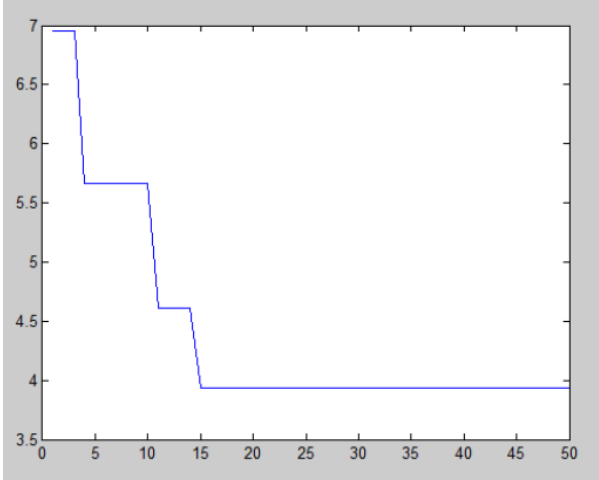
Figure 11. Convergence curve of the fitness function.